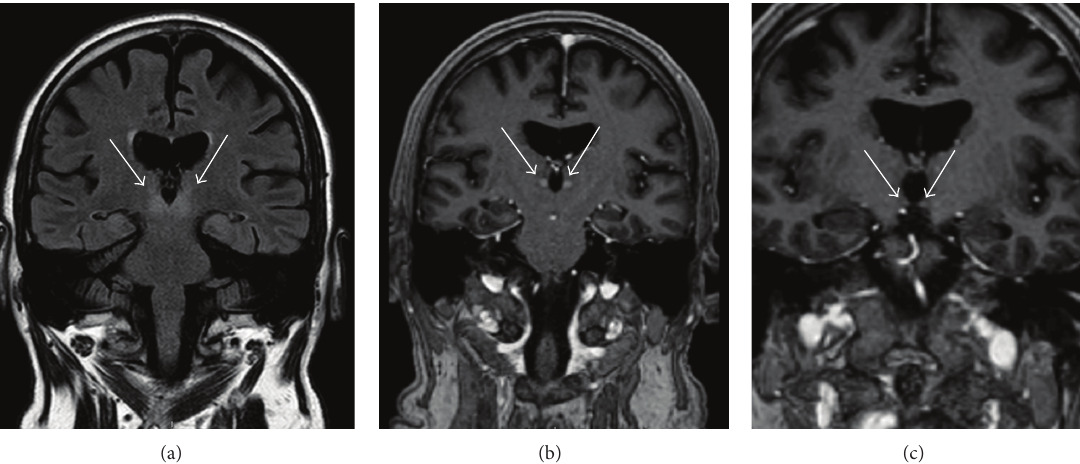
Figure 4: MR at day 3 showing hyperintense changes in both thalami adjacent to the third ventricle on FLAIR series (a) and Gd-enhancement in the thalami (b) and in the mammillary bodies